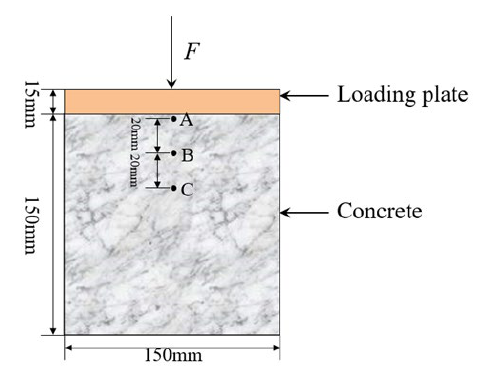
Figure 8. Simplified model of concrete dynamic tests.